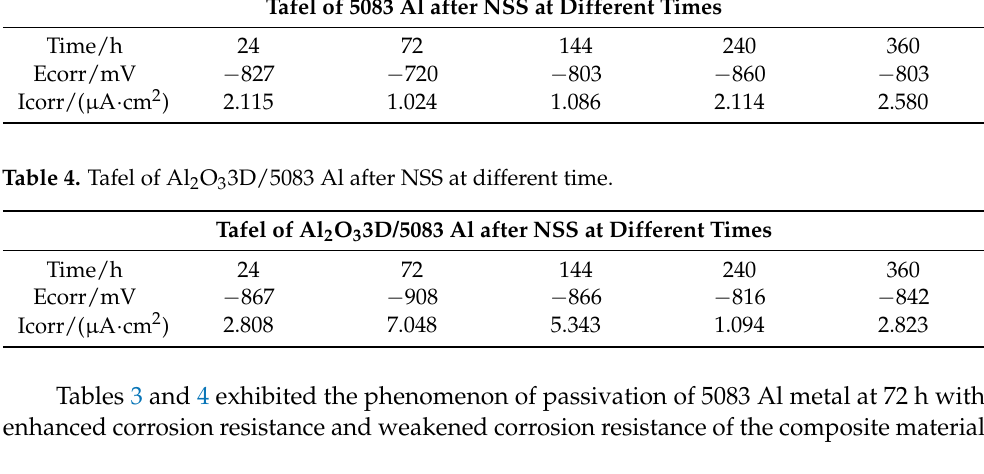
Table 3. Tafel of 5083 Al after NSS at different times. Tafel of 5083 Al after NSS at Different Times